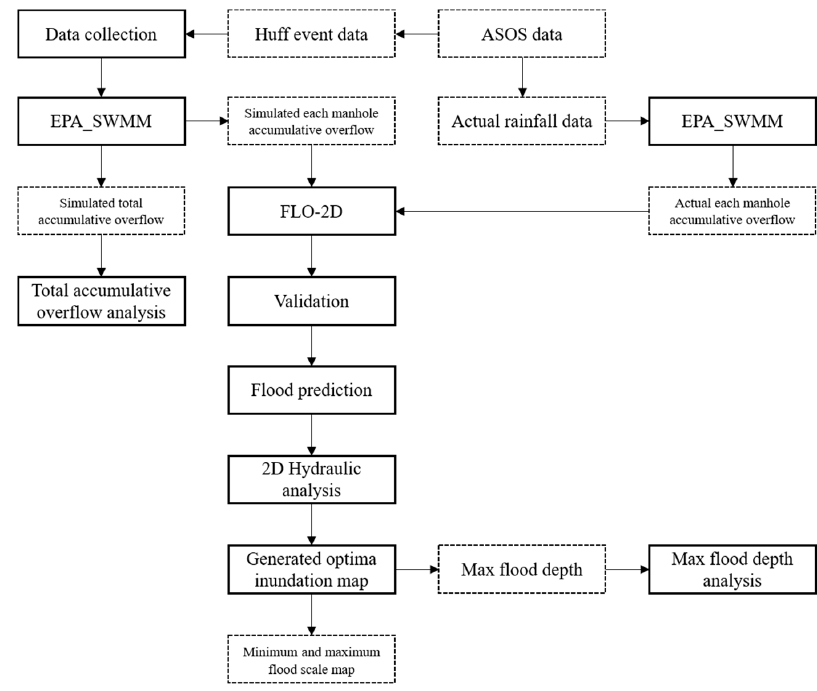
Figure 4. Flowchart of study methodology.